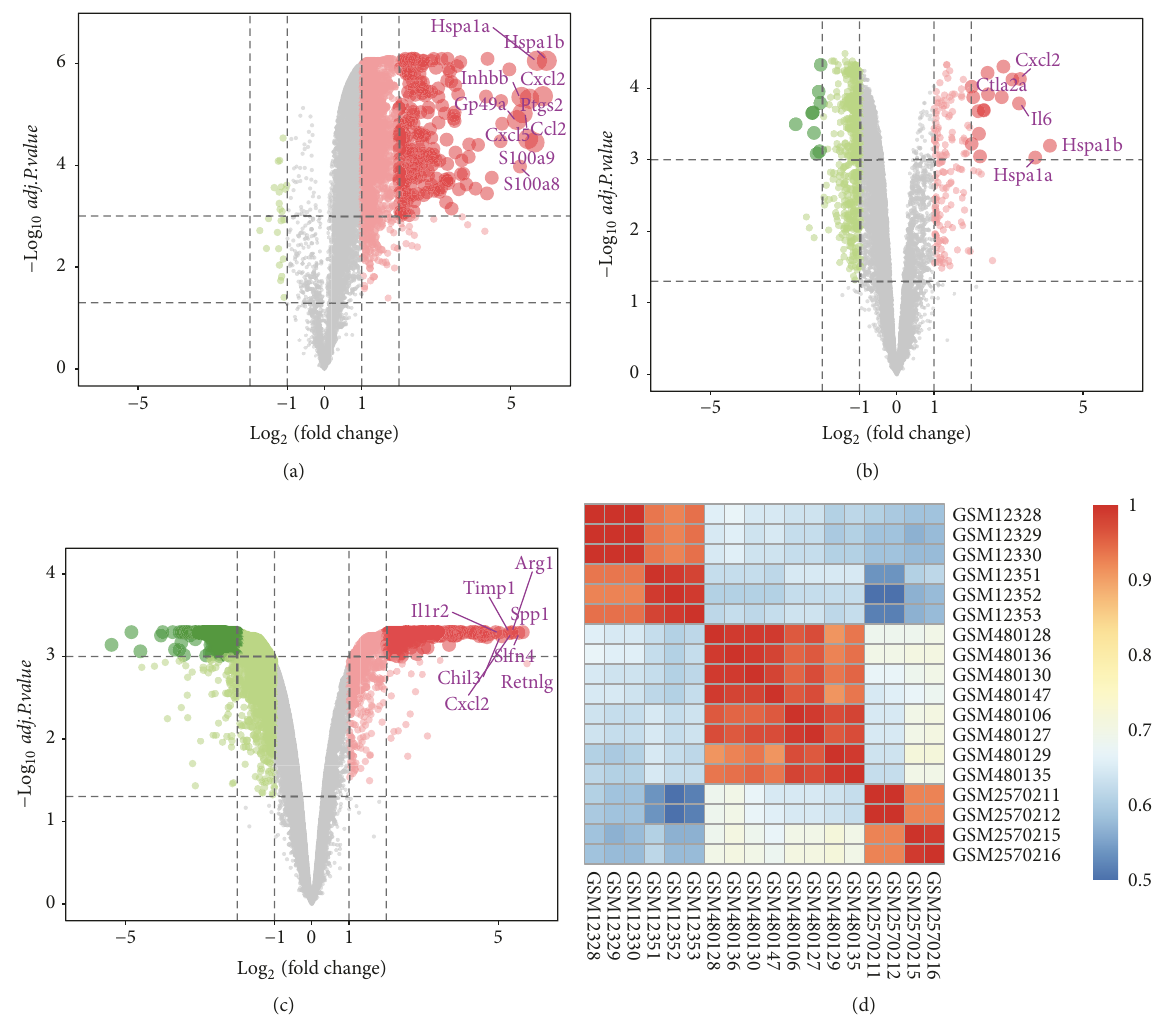
Figure 1: Volcano plot of gene expression profile data in AMI samples and sham-operation ones and correlation coefficientanalysis diagram. Notes: (a) volcano plot of GSE775, (b) volcano plot of GSE19322, and (c) volcano plot of GSE97494. The red, green, and gray points represent upregulatedgenes,downregulatedgenes,andnondifferentiallyexpressedgenes,respectively.Theyarescreenedonthebasisoflog2FC > 1.0and a corrected p < 0.05. (d) Correlation coefficient analysis diagram. Each column and row, respectively, represents one sample. Red represents strong correlation between samples and grey represents weak correlation between samples. Different shades of colors indicate the different correlation degree. Abbreviation: AMI, acute myocardial infarction; DEGs, differentially expressed genes; FC, fold